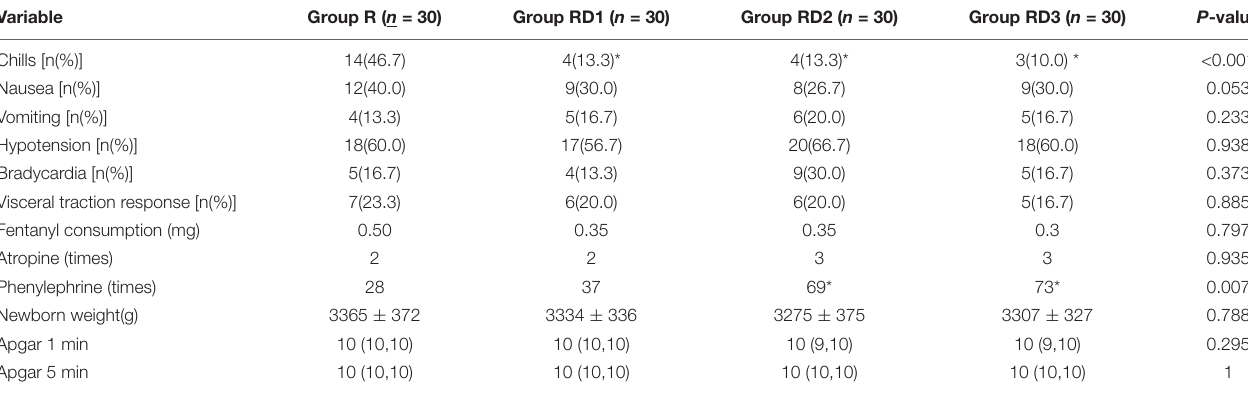
TABLE 3 | Intraoperative adverse reactions [n(%)], vasoactive drugs (times), fentanyl (mg) and neonatal conditions. Variable Group R ( n = 30)